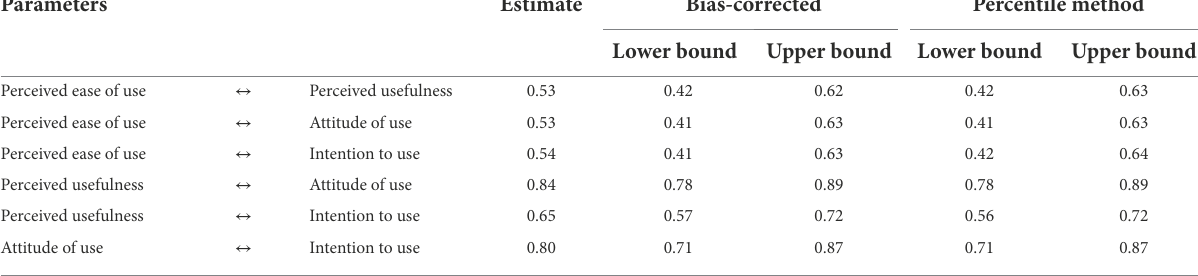
TABLE 5 Technology acceptance model - bootstrap correlation coefficient 95% confidence interval.